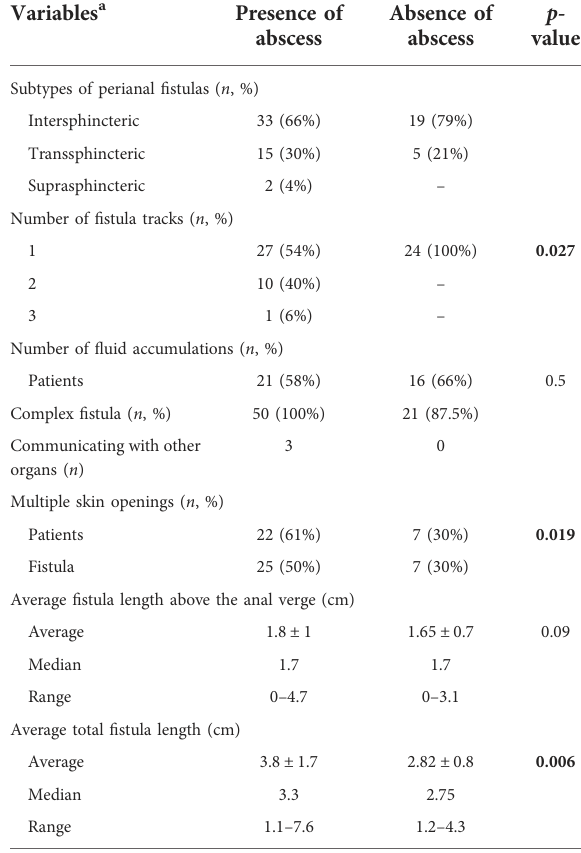
TABLE 2 MRI characteristics of the study